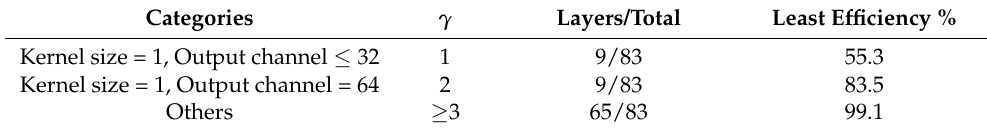
Table 2. The computational efficiency of different convolutional network layers. Categories